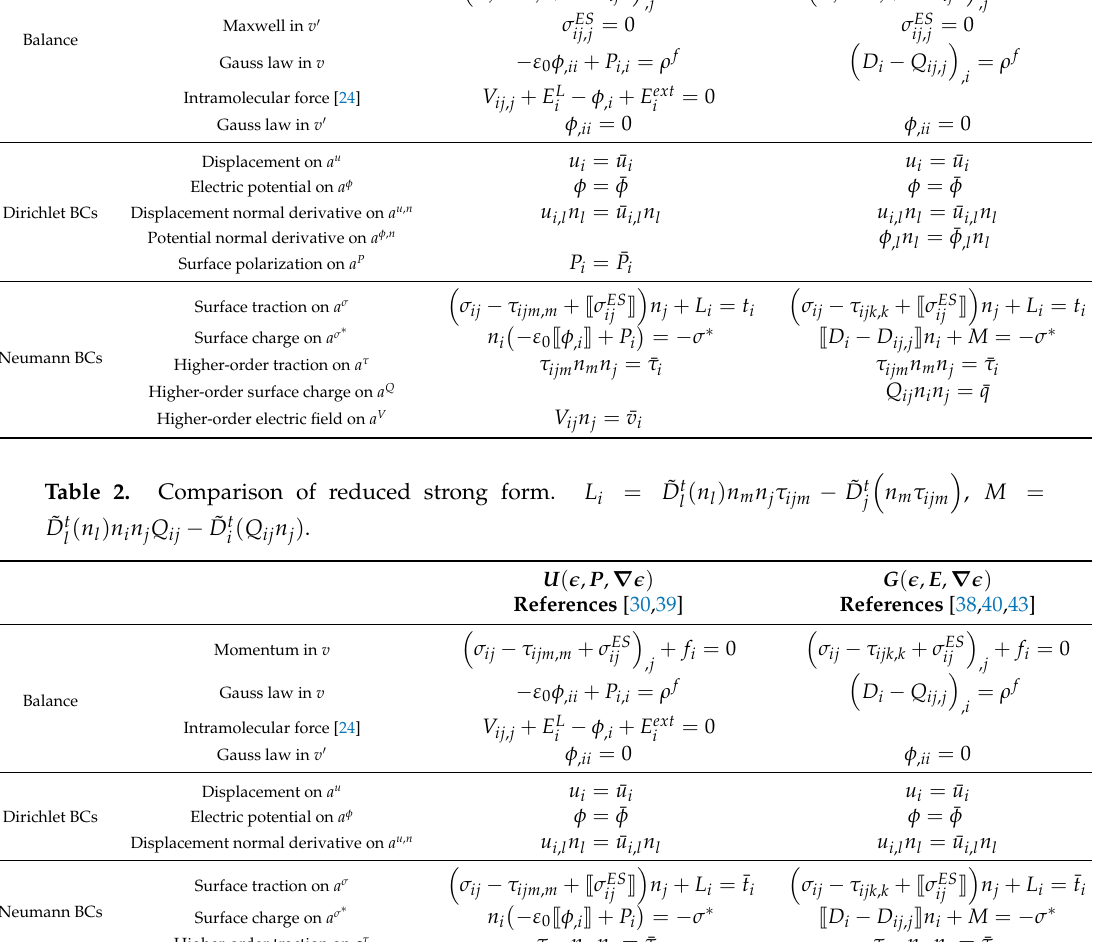
Table 1. Comparison of strong form. L i = ˜ D t ˜ D t ( Q ) . ij n j i